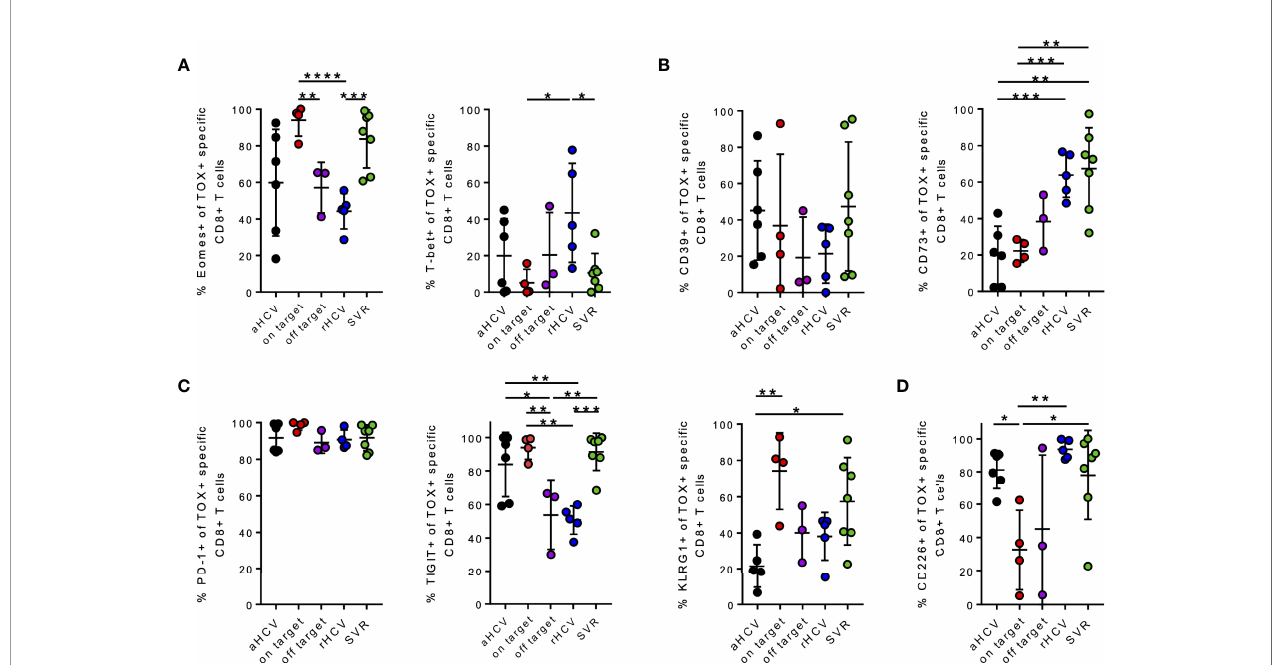
FIGURE 3 | (A – D) Phenotypic analysis of the indicated markers on TOX+ virus-speci fi c CD8+ T cells at different stages of hepatitis C infection. (A – D) Co-expression of the indicated markers of TOX+ virus-speci fi c CD8+ T cells in all different stages of hepatitis C infection; acute HCV = aHCV, chronic HCV with on-target T cells = on target, chronic HCV with off-target T cells = off target, spontaneously resolved HCV =rHCV, and successfully treated patients with a sustained virologic response = SVR. Data are shown as mean ± SD, where *, **, ***, and **** indicate P values <0.05, <0.01, <0.001, and